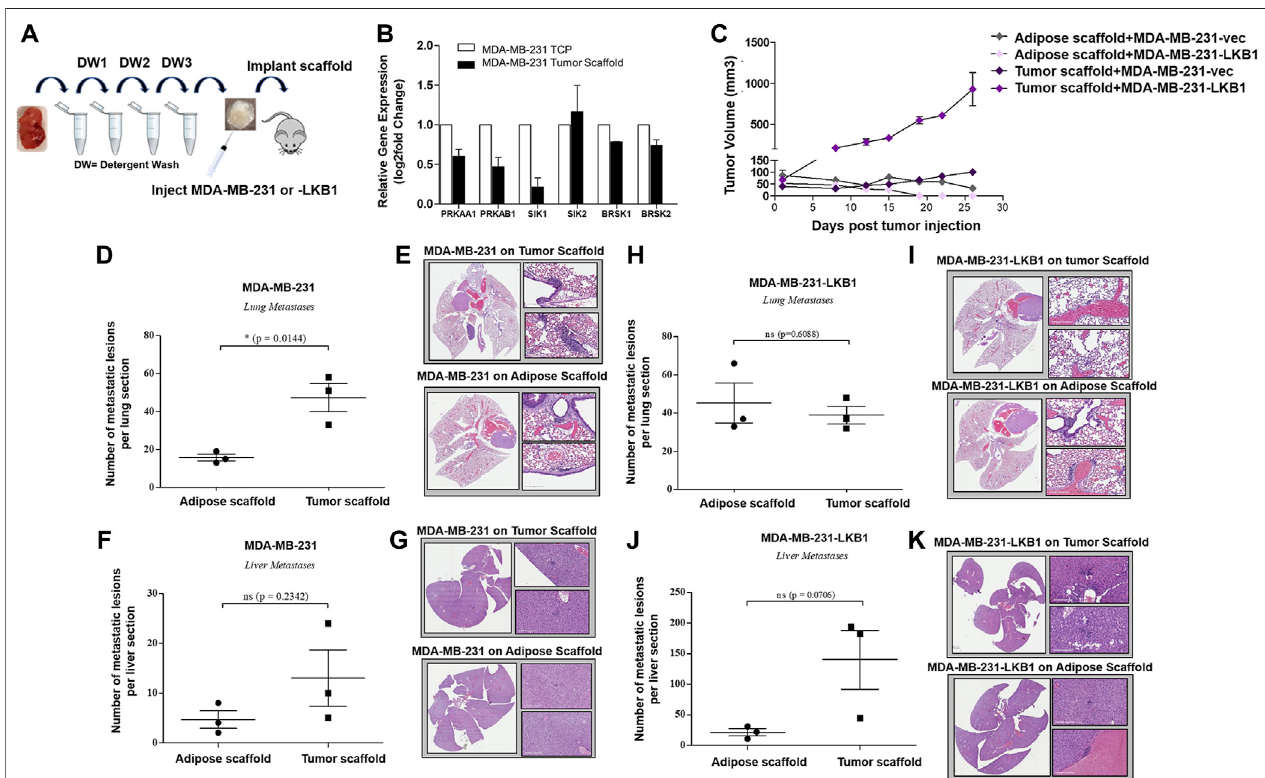
FIGURE1| Tumorscaffoldenhancestumorigenesisandmetastasis. (A) Schematicforimplantationofdecellularizedtumorandadiposescaffolds invivo . (B) MDA- MB-231 parental cells were seeded on tumor scaffolds for 24 h and evaluated ex vivo via qRT-PCR for LKB1- and LKB1-associated genes (PRKAA1, PRKAB1, SIK1, SIK2, BRSK1, and BRSK2). LKB1 was not detected in MDA-MB-231 cells. Normalization was to MDA-MB-231 cells seeded on tissue culture plastic (TCP), housekeeping gene was GAPDH, and error bars represent SEM, n = 2. (C) Average tumor growth for MDA-MB-231 and MDA-MB-231-LKB1 cells seeded on tumororadiposescaffoldsimplantedintheM.F.PsofSCID/beigemice. (D – G) EndpointnecropsyformetastaticlesionsinSCID/beigemiceimplantedintheM.F.Pswith MDA-MB-231 cells seeded on tumor and adipose scaffolds. Results represent (D) the number of lung lesions and (E) representative H&E images of the lungs, (F) numberofliverlesions,and (G) representativeH&Eimagesofthelivers. (H – K) Endpointnecropsyformetastatic lesionsinSCID/beigemiceimplanted intheM.F.Pswith MDA-MB-231-LKB1 cells seeded on tumor and adipose scaffolds. Results represent (H) the number of lung lesions and (I) representative H&E images of the lungs, (J) number ofliverlesions,and (K) representative H&Eimagesofthelivers. N =3mice per group forall groups.Organswereharvested at necropsyand wereformalin- fi xed and paraf fi n-embedded before staining. DW1-3 = detergent washes 1 – 3.